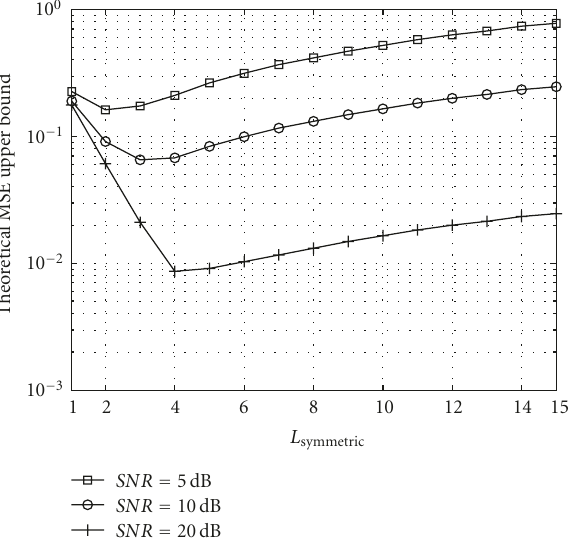
Figure 5: LNR comparison when M = 64.